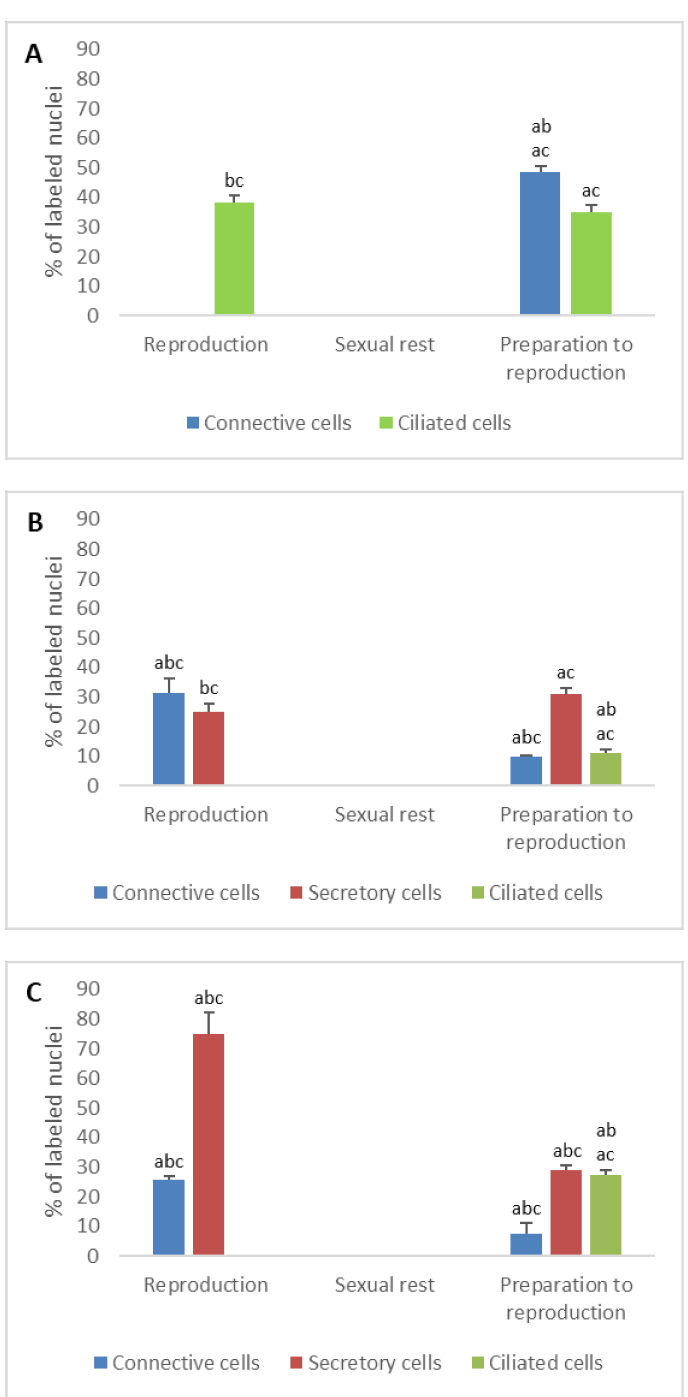
Figure 4. Percentage of ER β immunodetected in the different cell types of the genital tract of Typhlonectes compressicauda before ovulation and during the reproduction period (pregnant females) and sexual rest (quiescent females). Significant differences (ANOVA, α = 0.05) between the 3 groups of females (a: before ovulation; b: pregnant females; c: quiescent females) are reported with the letters a, b, c. ( A ) Ostium (connective cells n = 6, Pr > F < 0.0001, ciliated cells n = 6, Pr >F: 0.000); ( B ) Tubal part (connective cells n = 6, Pr > F: 0.004, secretory cells n = 6, Pr > F: 0.001, ciliated cells n = 6, Pr > F: 0.000); ( C ) Uterus (connective cells n = 6, Pr > F: 0.003, secretory cells n = 6, Pr > F: 0.001, ciliated cells n = 6, Pr > F: